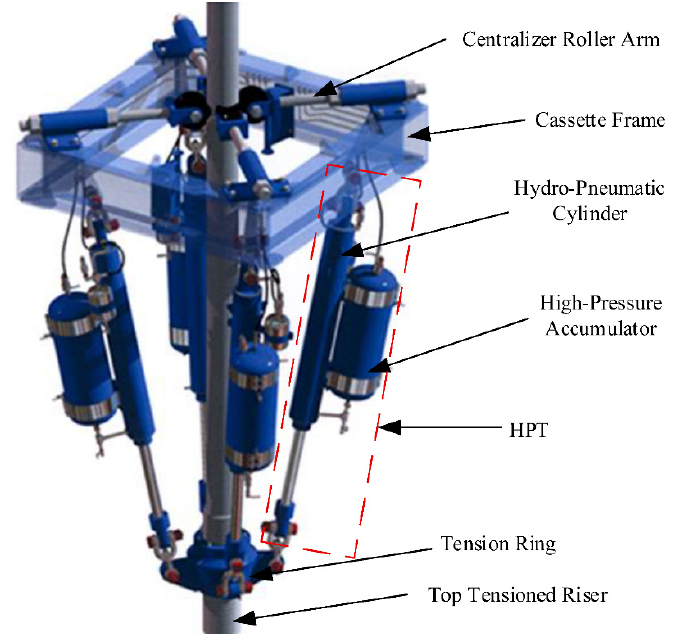
Figure 1. Schematic of DAT system.